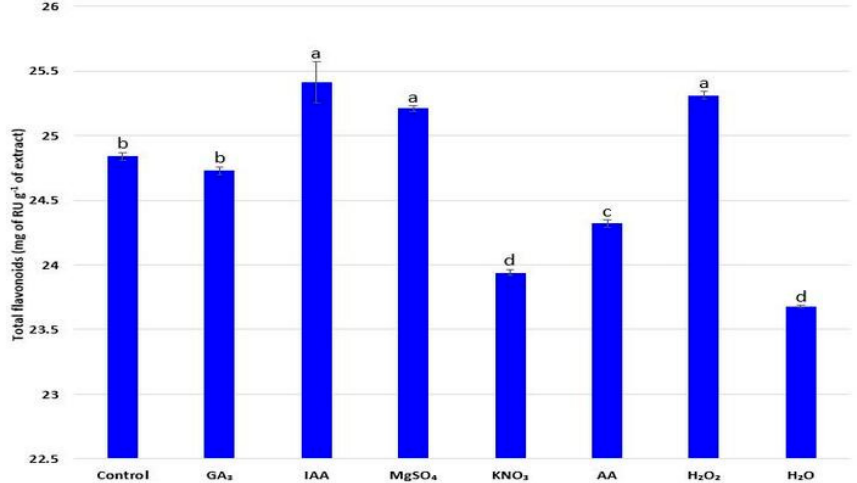
Figure 5. Influence of different priming treatments on concentration of flavonoids (mg of RU g − 1 of extract) in the aboveground part of radish ( R. sativus ) seedlings; the values represent the means of six replicates ± standard error. Different letters indicate significant differences ( p ≤ 0.05) between treatments according to Tukey’s test.